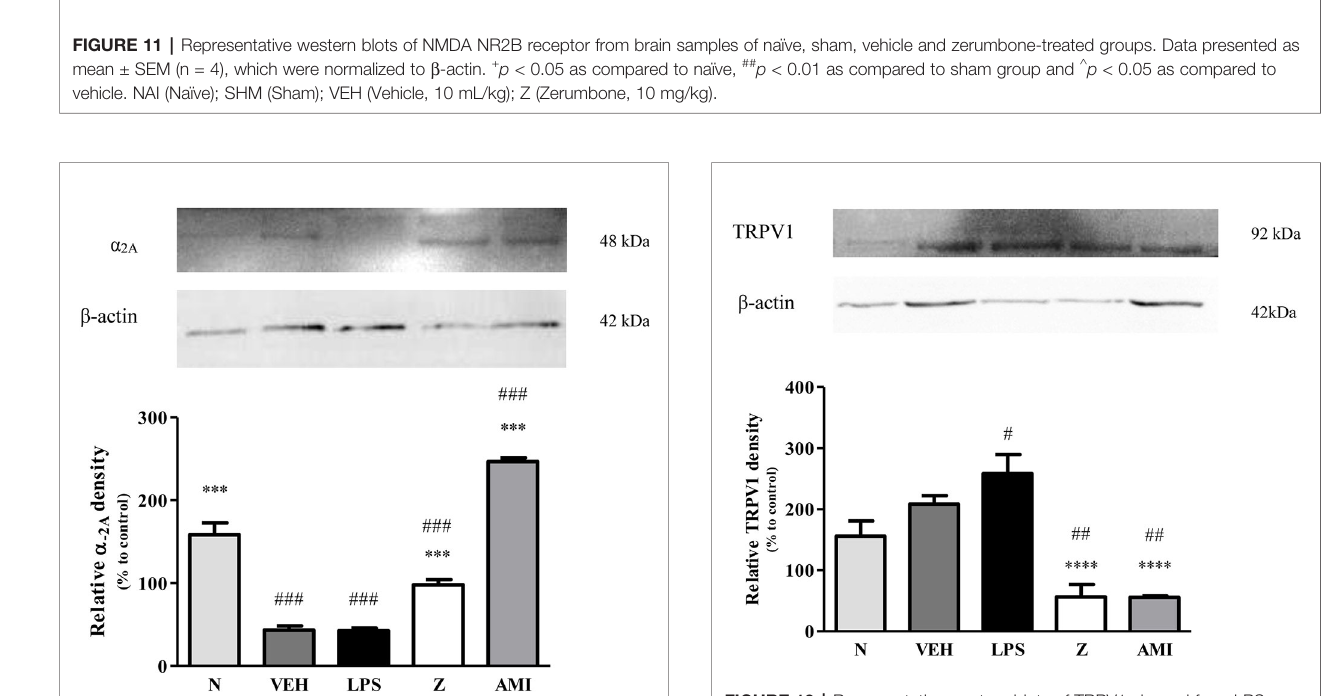
FIGURE 13 | Representative western blots of TRPV1 channel from LPS- induced SH-SY5Y cells samples of normal, vehicle, LPS only, zerumbone, amitriptyline-treated groups. Data presented as mean ± SEM (n = 4), which were normalized to b -actin. **** p < 0.0001 as compared to LPS only group and # p < 0.1, ## p < 0.01 as compared to normal group. N (Normal); VEH (Vehicle, PBS); Z (Zerumbone, 8 m g/ml); AMI (Amitriptyline, 16 m